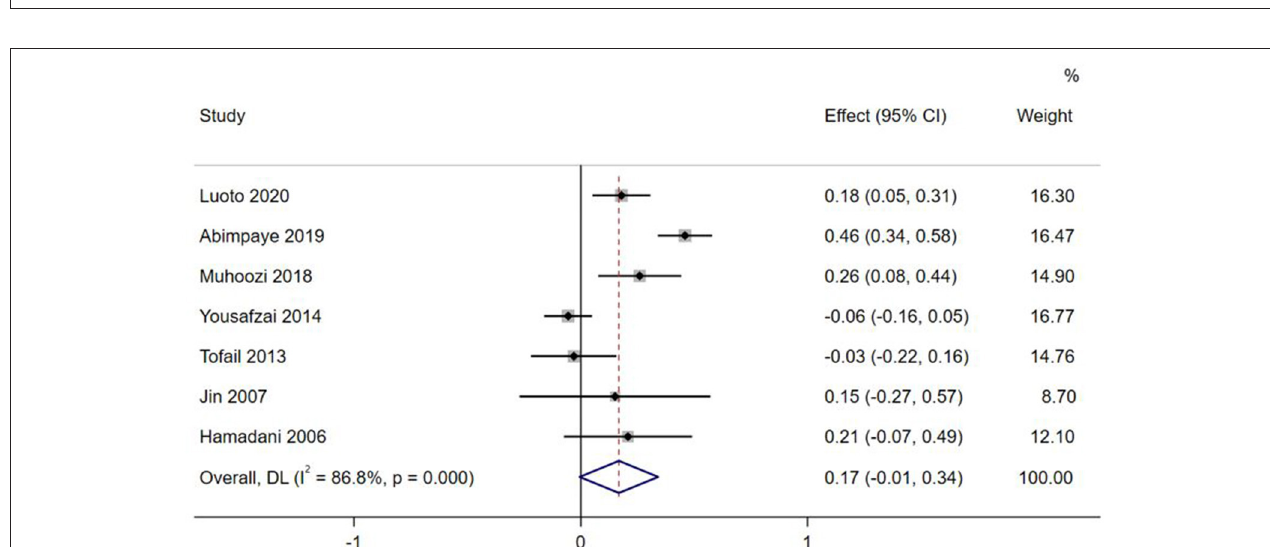
on the effect sizes on motor skills outcomes. Effect sizes were greater for children in rural areas compared to urban settings (ES = 0.29 vs. 0.11, Q = 5.2, p = 0.02). Thus, consistent